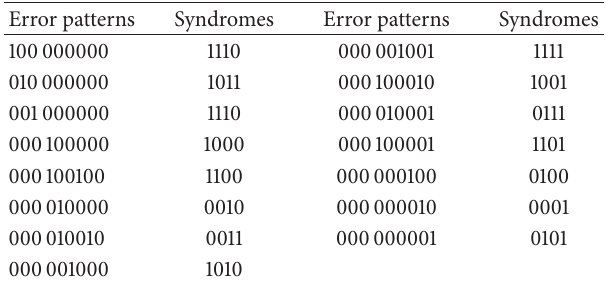
Table 2: Error pattern